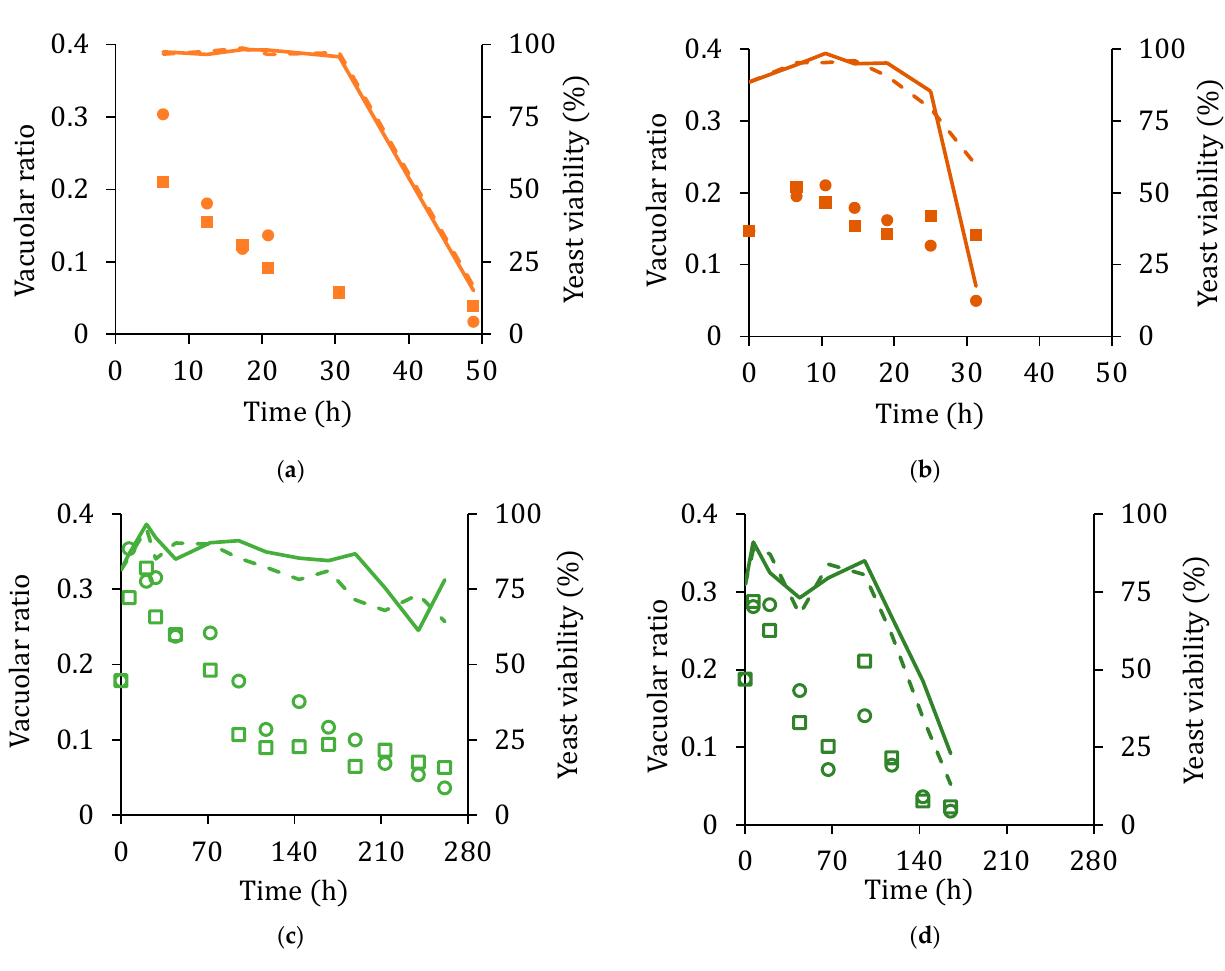
Figure 8. Vacuolar ratio (total vacuolar CSA to total yeast cell CSA) plotted over time: ( a ) LTHF (orange); ( b ) HTHF (dark orange); ( c ) LTLF (green); ( d ) HTLF (dark green). Fermentations were performed in duplicate. The data shown represent vacuolar ratio under vacuum (circles) and atmospheric conditions (squares); high FAN (filled) and low FAN (empty); high temperature (darker shade) and low temperature (lighter shade); yeast viability (continuous and dotted lines).